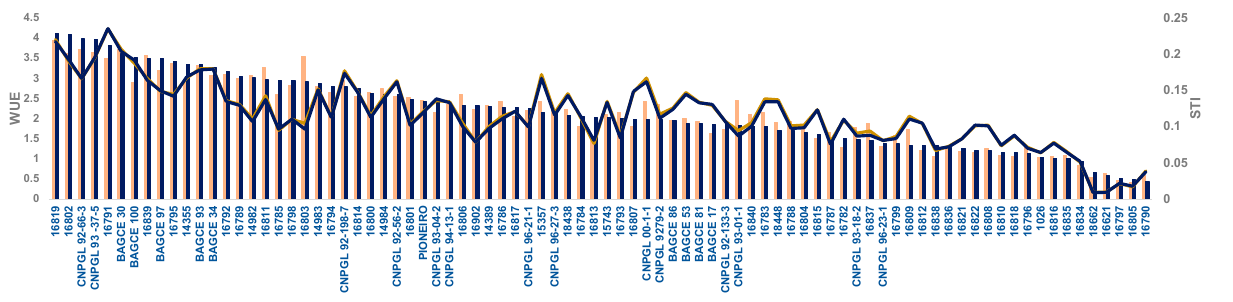
Figure 2. Water use efficiency (WUE-Bar graph) and stress tolerance index (STI-Line graph) profile of Napier grass genotypes grown under moderate water stress (light brown) or severe water stress (blue black) conditions. The order of genotypes from left to right is based on WUE rank (1 to 84) under severe water stress.